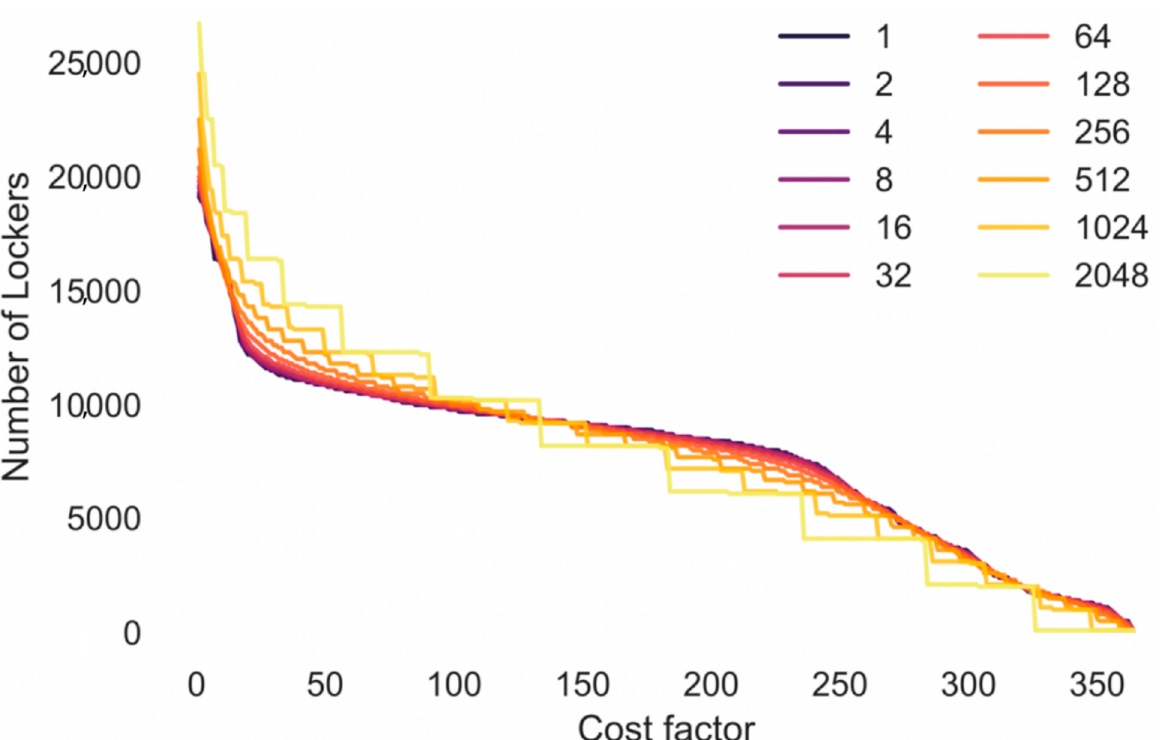
Figure 9. Optimal number of lockers depending on the costs and number of CDPs (Density 1.0).